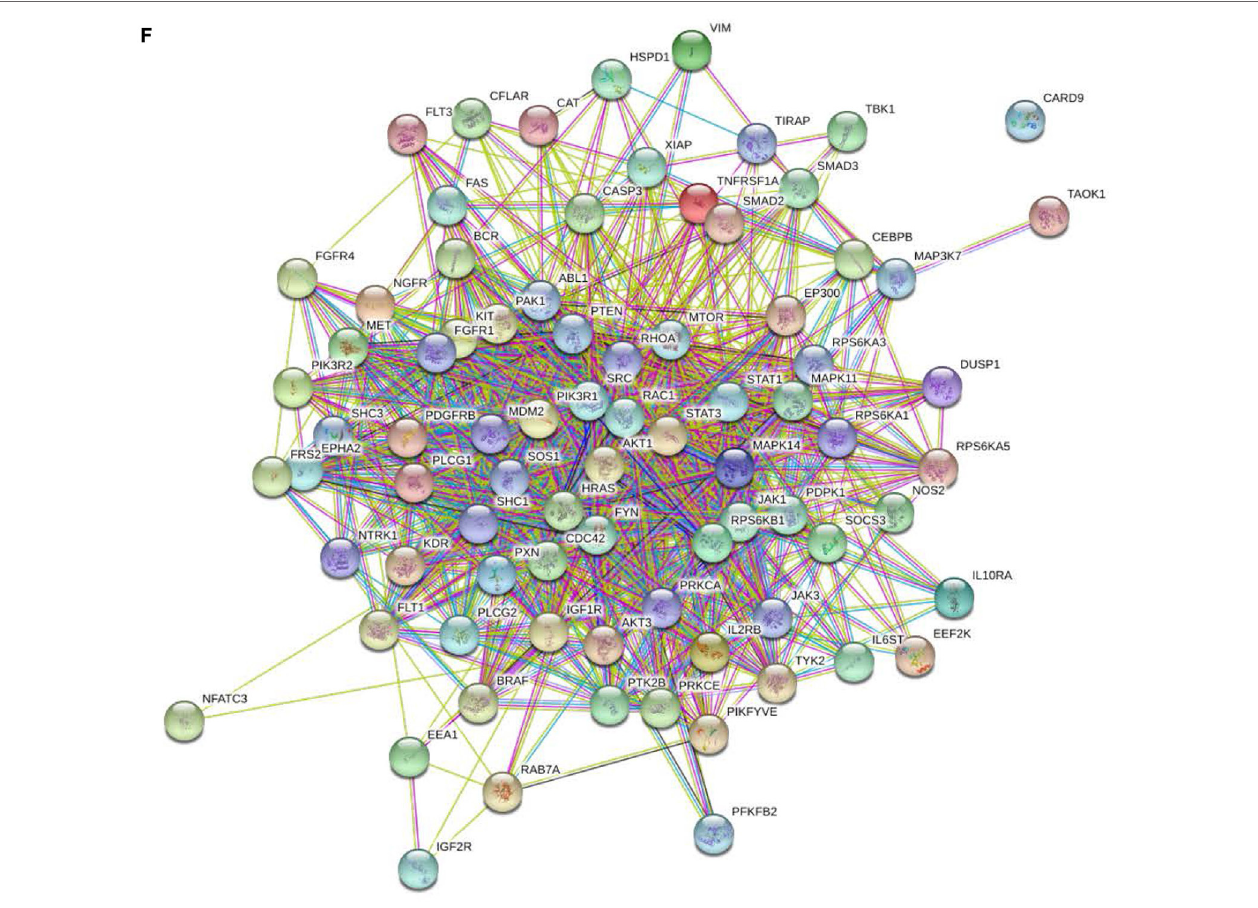
FigUre 2 | Protein–protein interactions. Predicted protein–protein interactions generated following analysis of significantly different peptides input into the STRING database: (F) late high interactions.